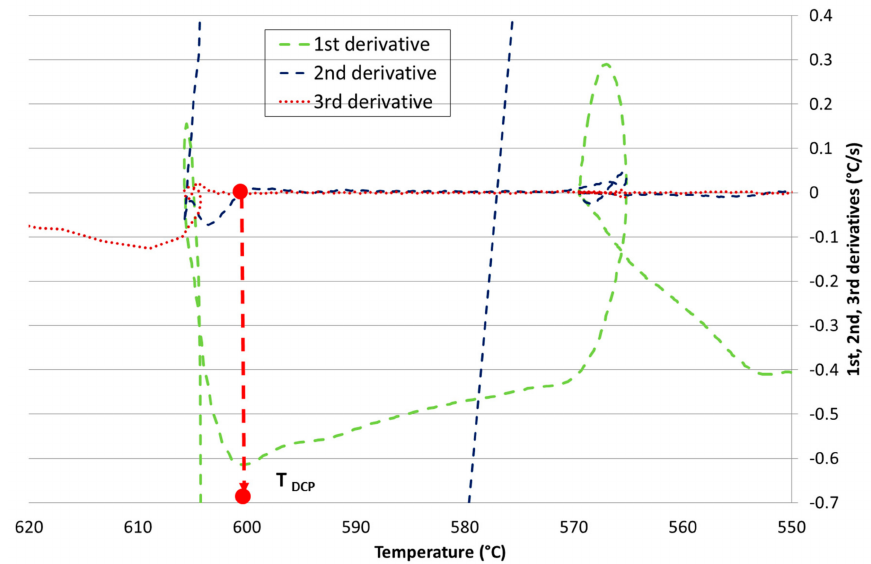
Figure 7. Method 6: the DCP determination at the crossing point of the second and third derivative of dT/dt vs. T curve.